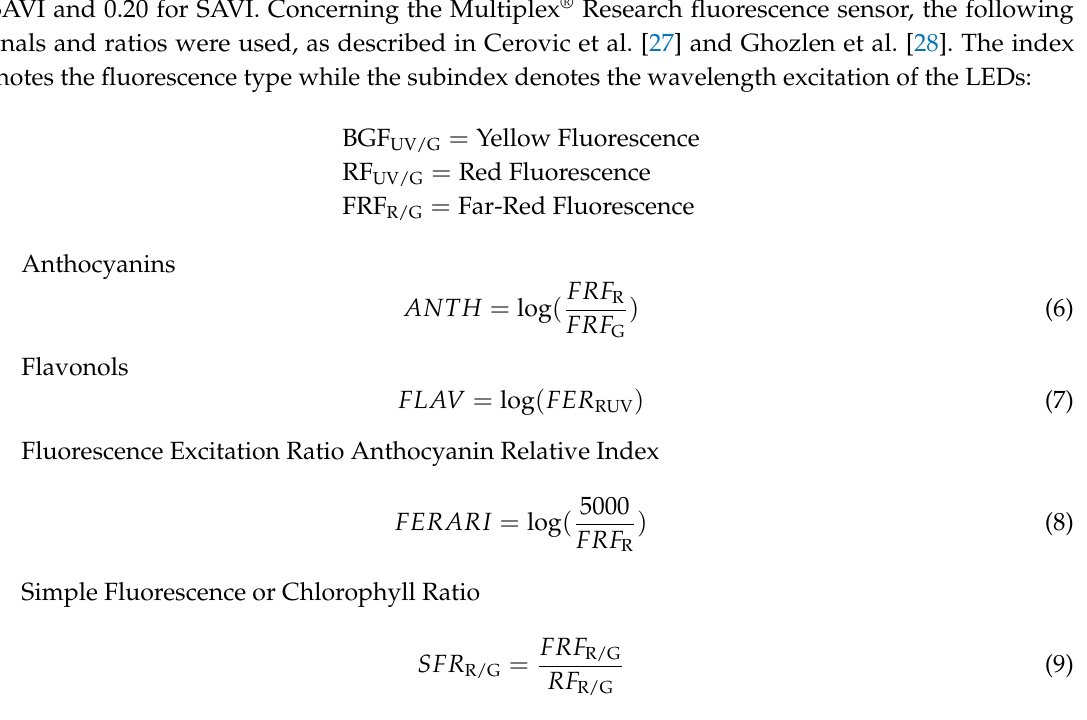
Table 4. Average grain yield (t content at the different N levels (kg